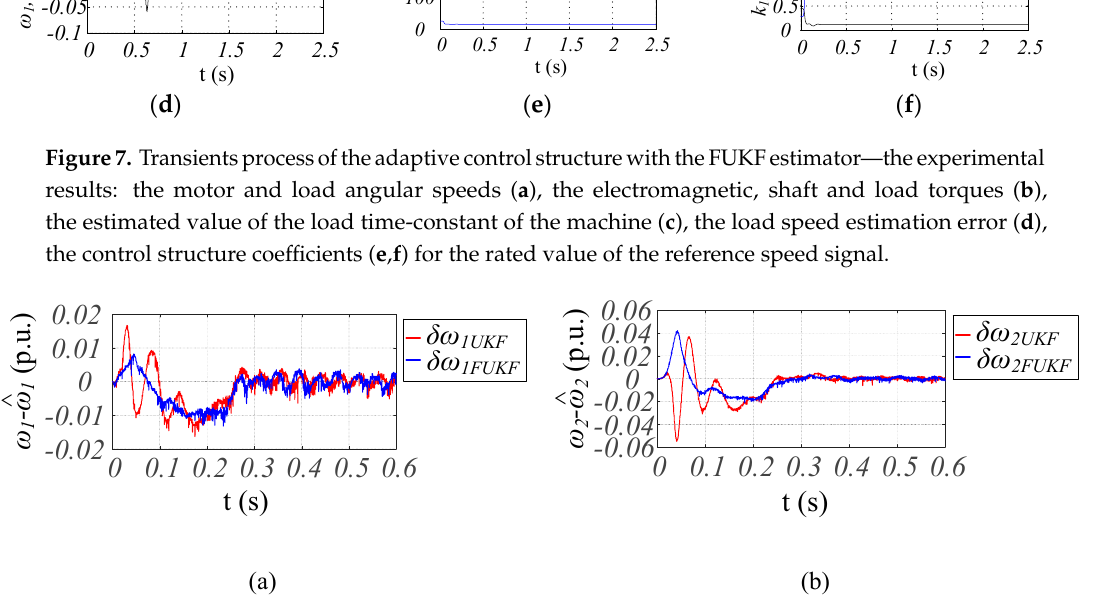
Figure 8. Experimental transients of the speeds estimation errors for the UKF and FUKF estimators: the motor speed error ( a ) and the load speed error ( b )